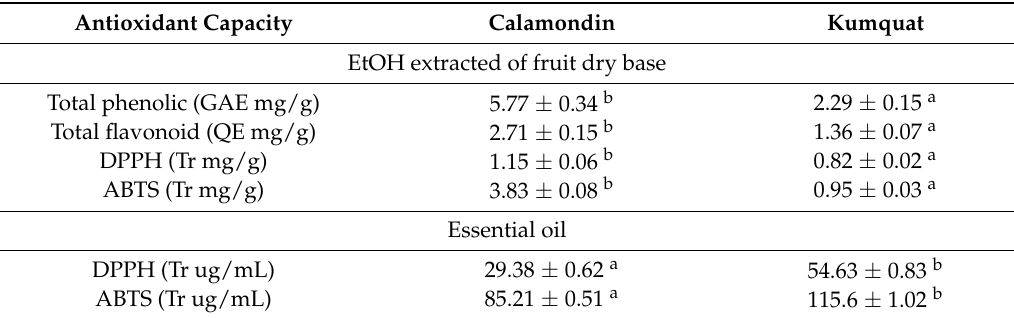
Table 3. Assay for total phenol, total flavonoid, ABTS and DPPH scavenging abilities of small-size